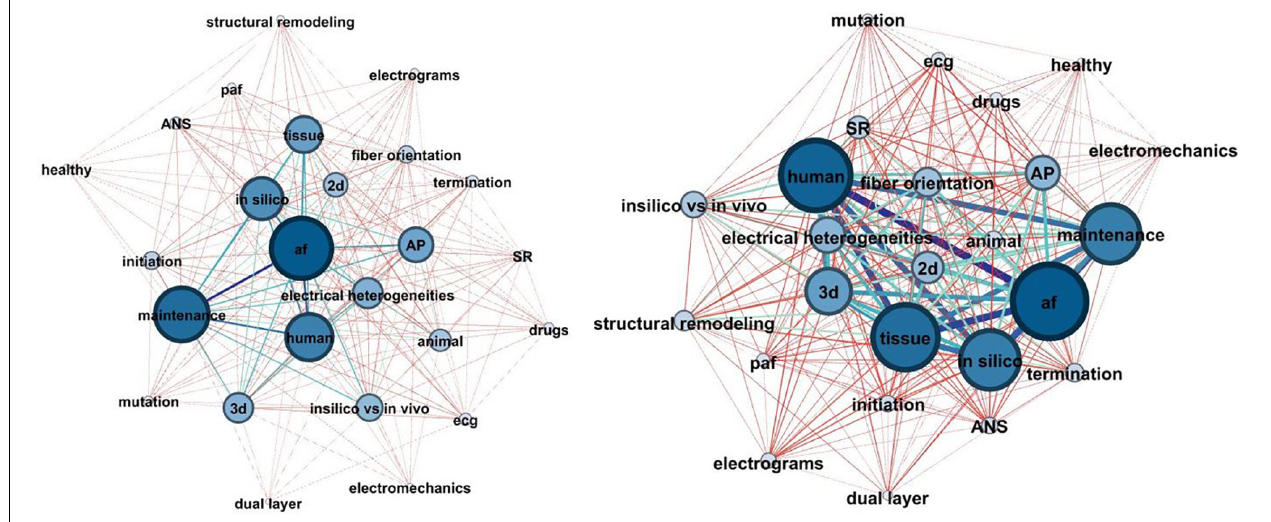
FIGURE 8 | The network chart depicted the evolution of AF modeling complexity during the last 20 years (1998–2008: left, 2009–2018: right). The nodes of the network represent the basic components of the AF modeling concept, and the edges represent their connections. The stronger the prevalence of the nodes and edges, the higher their thickness, and the darker their